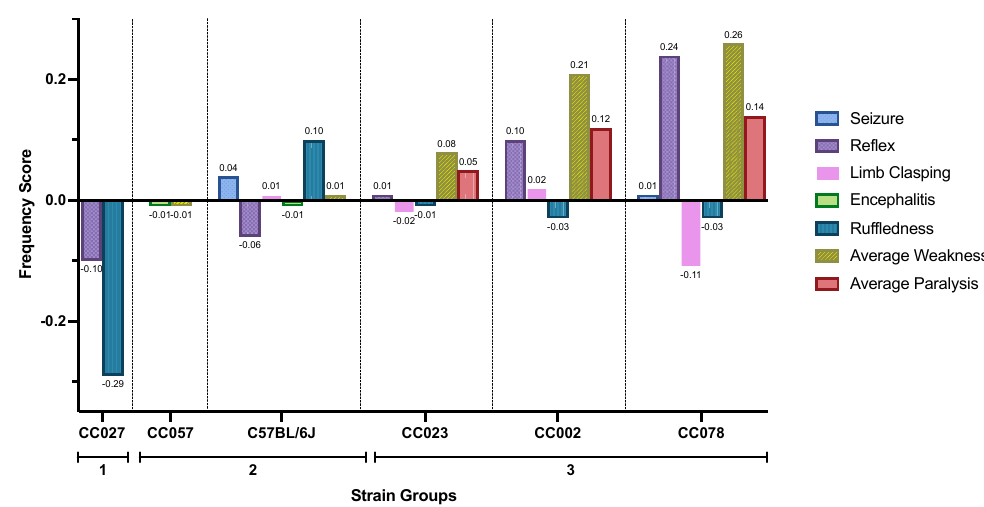
Figure 3. Cumulative progression scores of neurological phenotypes varied by strain. The difference between the cumulative scores for all neurological phenotypes (listed in the legend) between 4 and 14 d.p.i. summarized how each strain fared following TMEV infection. These scores are presented above or below each phenotype column. The y-axis shows the cumulative frequency score for each strain; these scores reflect the relative frequency difference of observation for each listed symptom over time. Positive frequency scores indicate symptoms worsened (more frequent) from 4 to 14 d.p.i.; negative scores indicate symptoms improved (less frequent) from 4 to 14 d.p.i. Each CC strain is listed along the x-axis by increasing the cumulative frequency score. These strains were classified based on whether their symptoms showed overall improvement (group 1), a balance between worsening and improving symptoms (group 2), or showed overall worsening (group 3). Not shown are phenotypes with scores of 0.